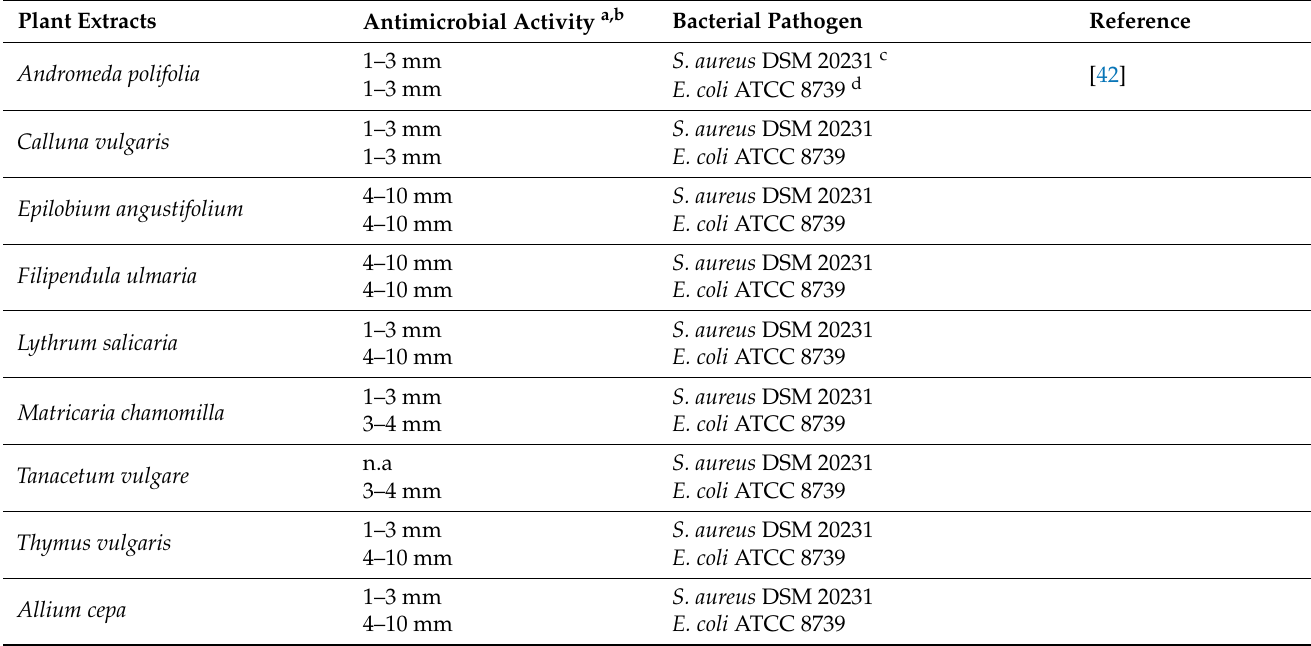
Table 1. Plant extracts and their antimicrobial activity against human bacterial pathogens. Plant